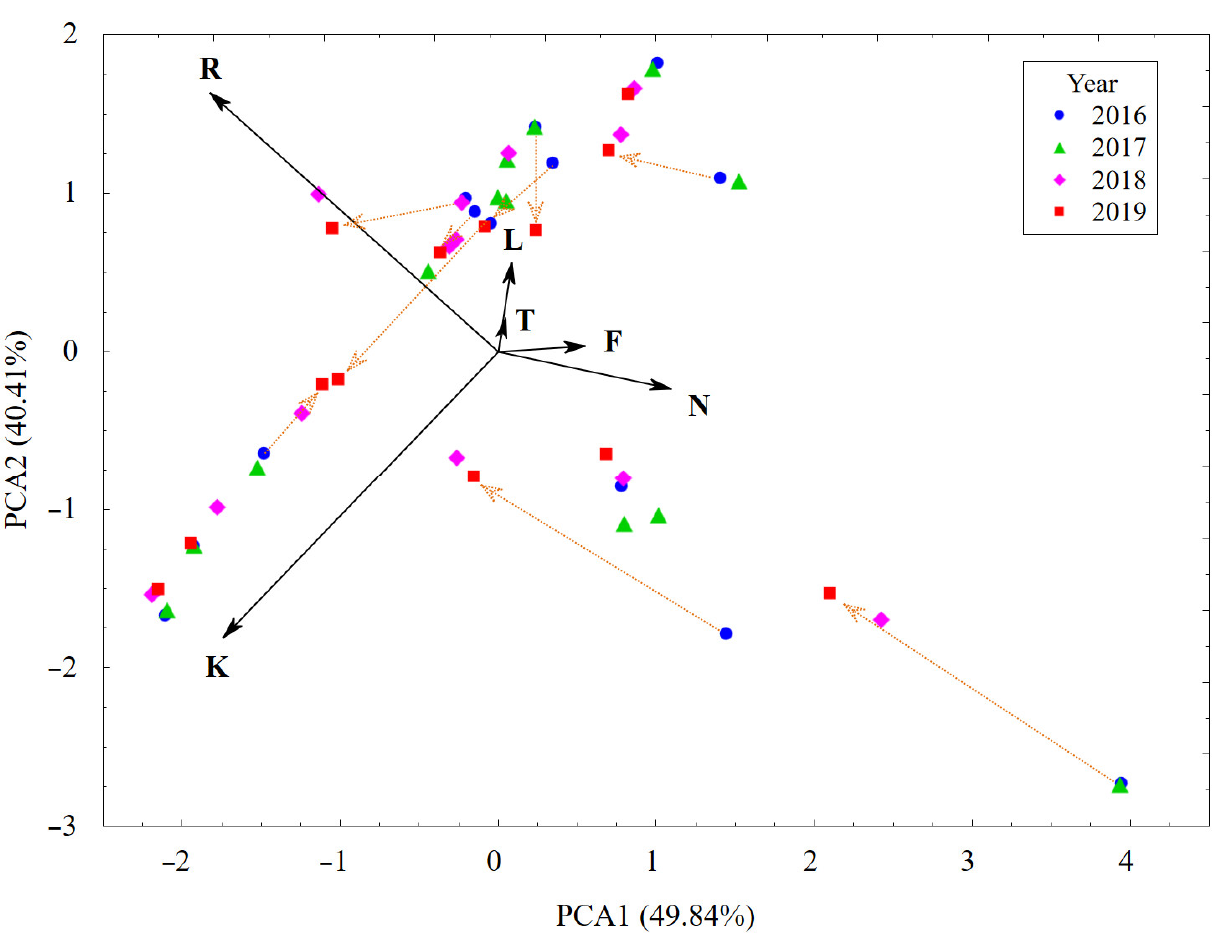
Figure 3. The PCA analysis scaled scatter plot of phytosociological relevés by Ellenberg ecological indices where: L—light, T—temperature, K—continentality, F—moisture, R—water/soil pH, N—nitrogen content. Black solid vectors show the contribution of the individual indices in the values of the principal components, while the orange dotted line vectors represent the trend of changes in indices for the particular phytosociological relev é s in